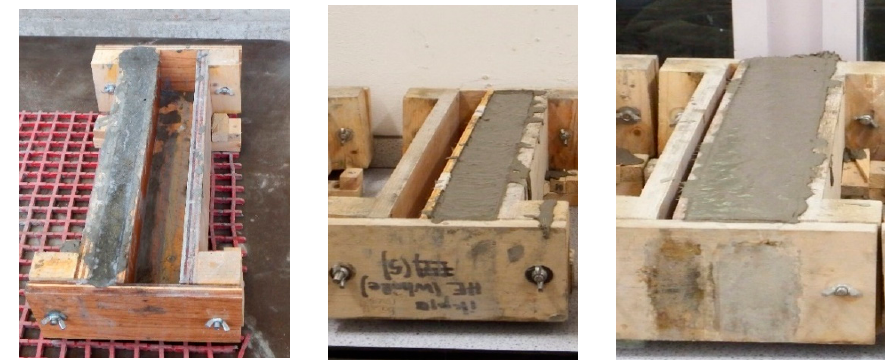
Figure 1. Preparation of prisms with different depths.